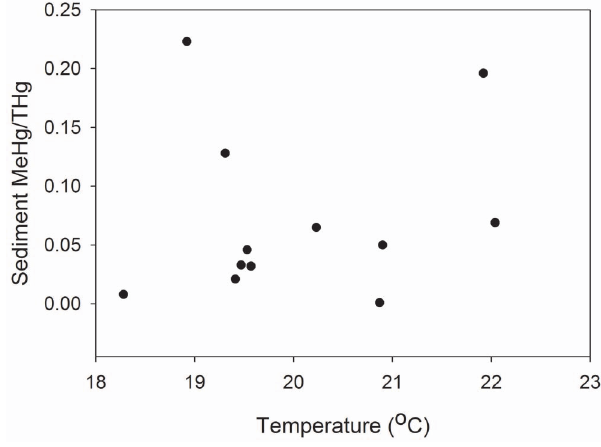
Figure 1. There is no relationship between temperature and %MeHg in sediments for 2009 and 2010 in pool habitats, indicating that temperature may not be affecting MeHg bioavailability and consequently fish exposure between